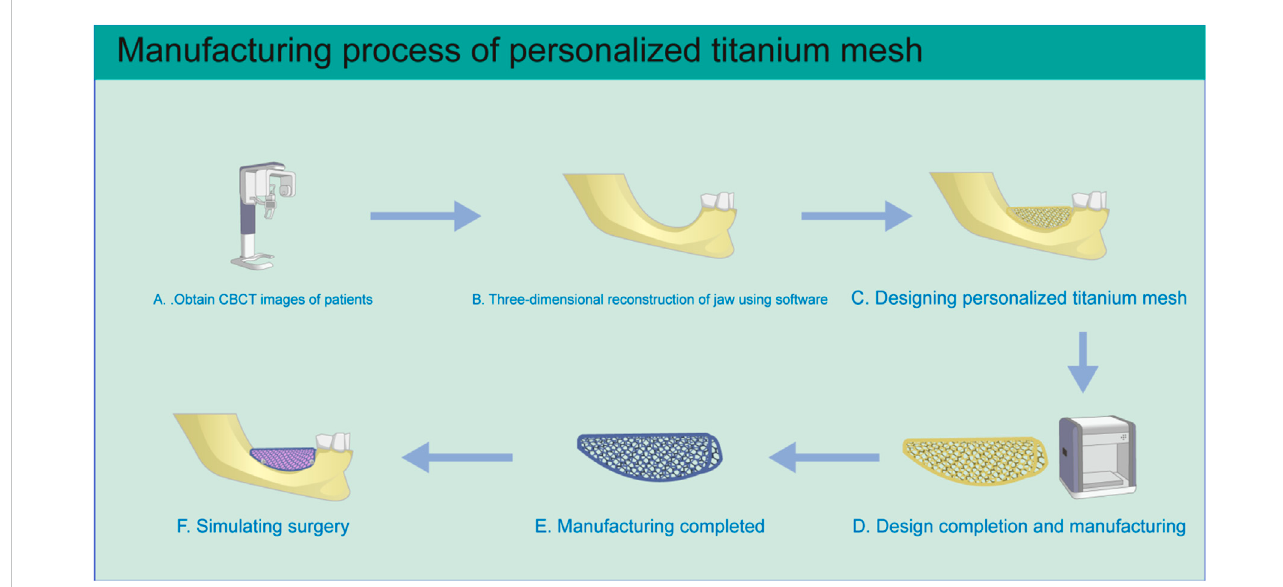
FIGURE 4 Schematic diagram of personalized titanium mesh production. (A) Three-dimensional CBCT image data of the patient ’ s jaws is obtained. (B) The three- dimensionaljawstructureisreconstructed. (C) Personalizedtitaniummeshisdesignedaccordingtotheconditionofalveolarbonedefect. (D) Afterthedesign is completed, the fi le is imported into the 3D printer for manufacturing. (E) After printing is completed, the titanium mesh is treated by ultrasonic cleaning, sandblasting, and acid etching. (F) The situation is simulated during the